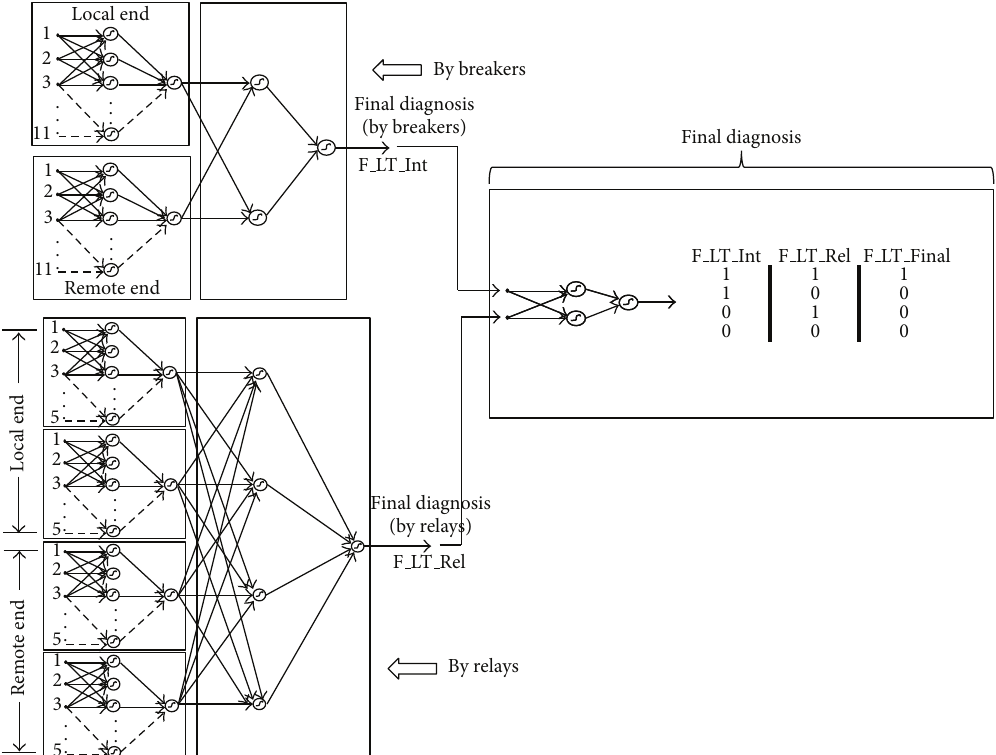
Figure 4: The complete neural structure for the diagnosis connected at both ends with “a breaker and a half”